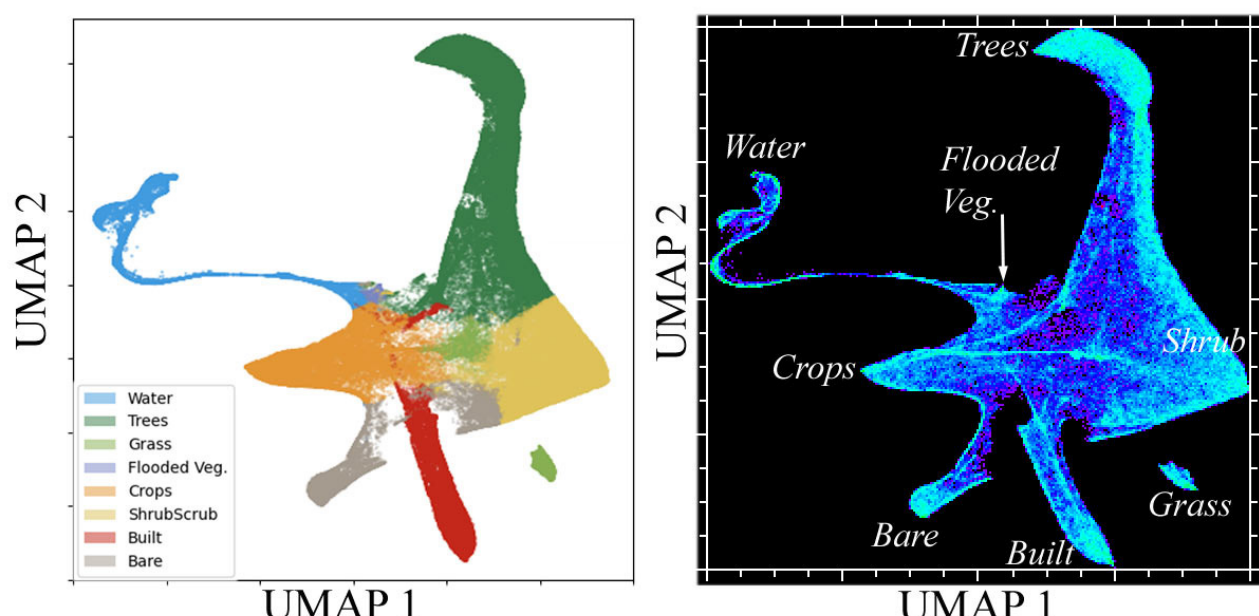
Figure 9. Class probability feature space for the nine-site composite. In contrast to the 3D projection of the PCs in Figure 8, the 2D UMAP manifold preserves the local structure, with continua spanning Trees, Crops, and Shrub, and more distinct limbs for Bare, Built, and Water. Grass forms a separate cluster in the UMAP projection but is relegated to higher PC dimensions because it contributes much less variance than the other classes. Density-shading of the feature space uses the same cool to warm color table as Figures 2 and 3.